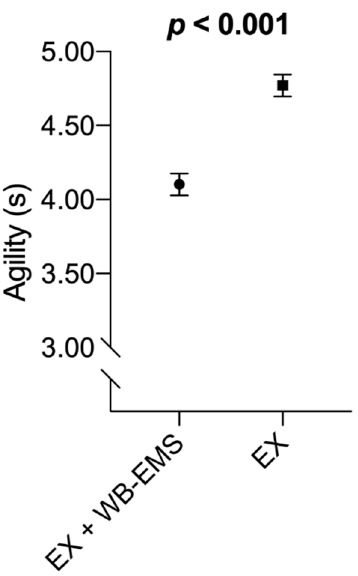
Figure 4. Analysis of covariance assessing differences in vertical agility at the end of the post-test among both groups. Estimated mean and 95% confidence intervals (CIs; error bars) represent values after adjusting by the corresponding value of the agility test at baseline. Statistically significant values are shown in bold. EX + WB-EMS: Voluntary exercise with WB-EMS; EX: Voluntary exercise group.